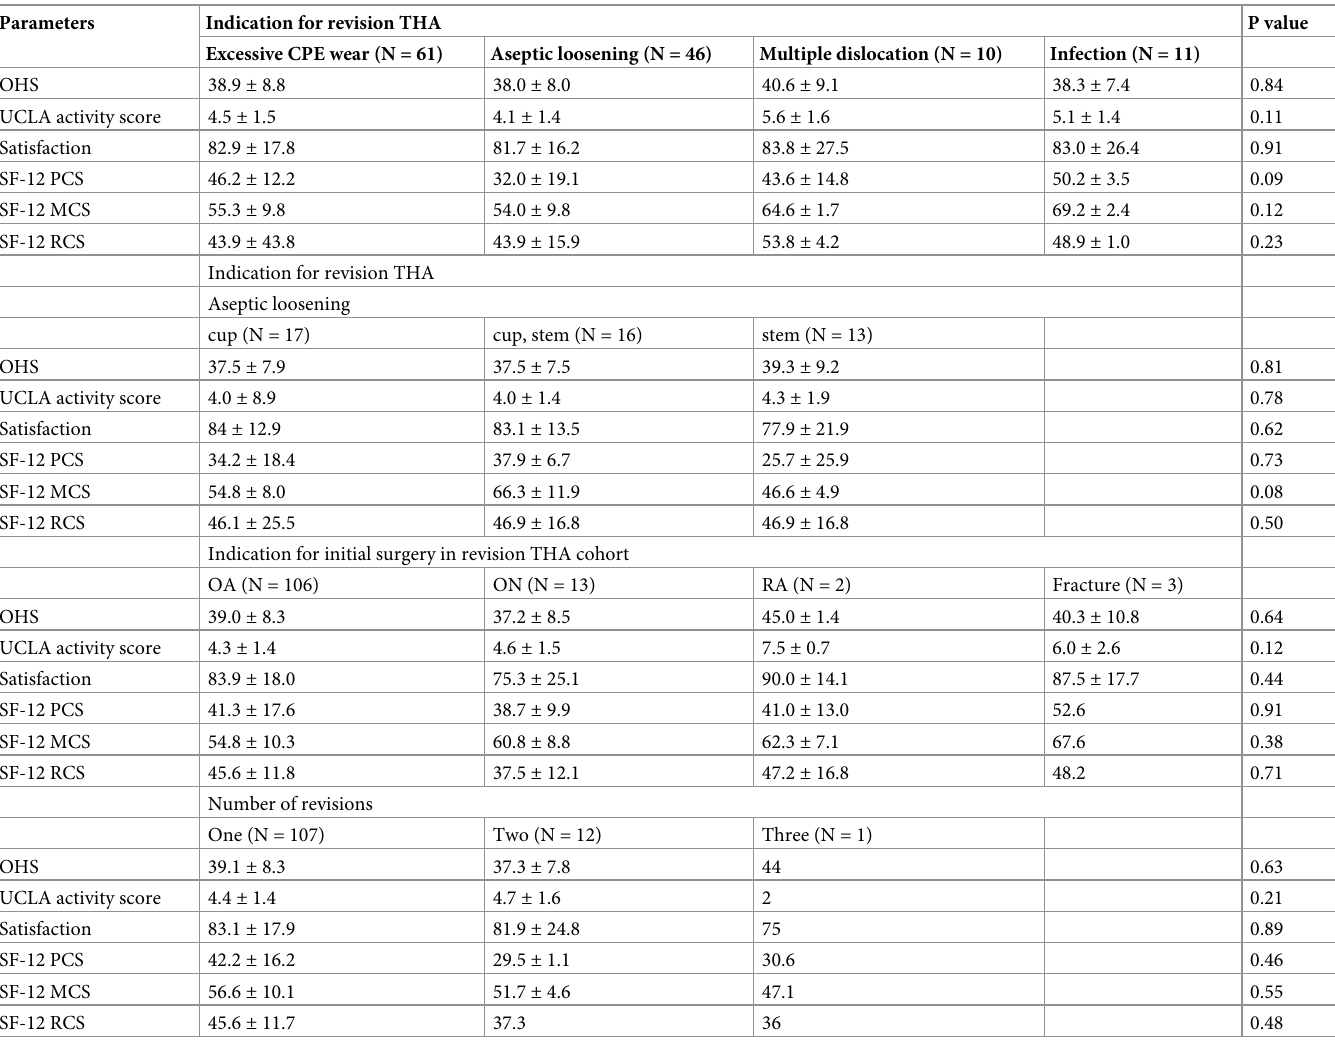
Table 4. Comparison of the patient-reported outcomes by reasons of revision THA.